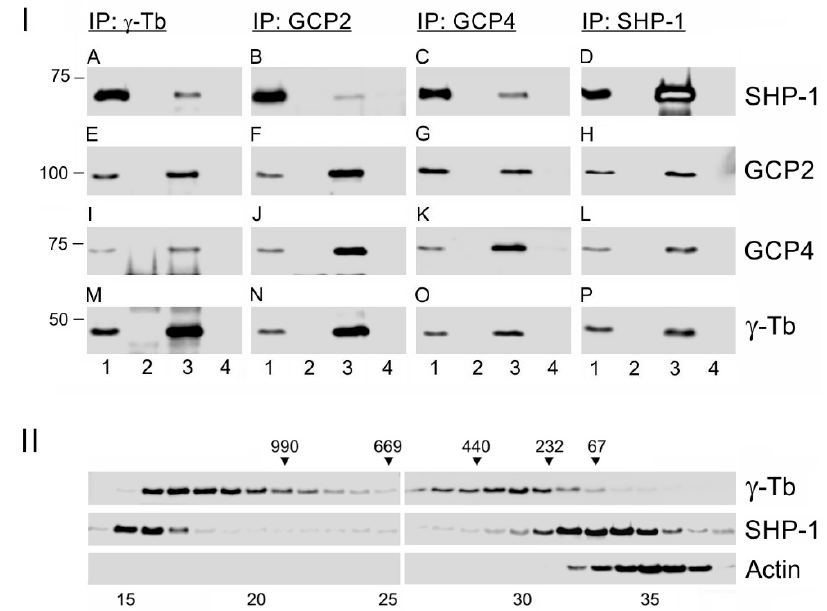
Figure 3. The SHP-1 associates with γ -tubulin complex proteins. ( I ) The immunoprecipitation experiments: Extracts from the BMMCs were precipitated with immobilized Abs specific to γ -tubulin ( A , E , I , M ), GCP2 ( B , F , J , N ), GCP4 ( C , G , K , O ), or SHP-1 ( D , H , L , P ). The blots were probed with Abs to SHP-1, GCP2, GCP4, and γ -tubulin ( γ -Tb). The load ( lane 1 ), the immobilized Abs not incubated with cell extracts ( lane 2 ), the precipitated proteins ( lane 3 ), and the carriers without Abs and incubated with cell extracts ( lane 4 ). ( II ) The size distribution of the proteins fractionated on Superose 6: The blots of the collected fractions were probed with Abs to γ -tubulin ( γ -Tb), SHP-1, and actin. The calibration standards (in kDa) are indicated on the top. The numbers at the bottom denote individual fractions.